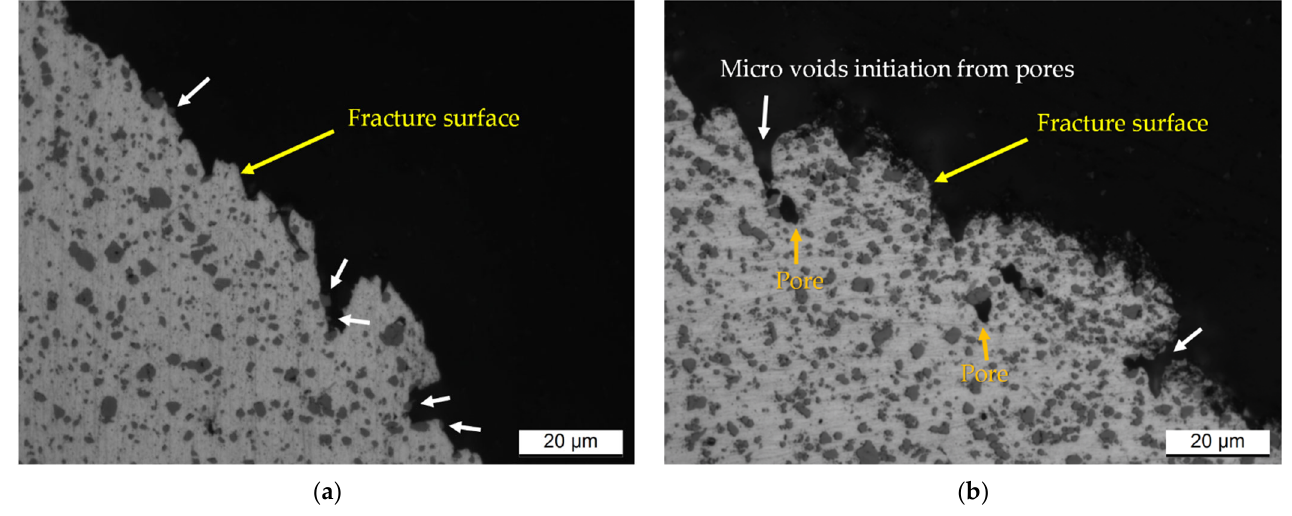
Figure 15. Longitudinal sections of the T6** AlSi10Mg0.3 samples showing: ( a ) the Si ‐ particles attached (white arrows) at the fracture surface, ( b ) the pores and the micro ‐ voids initiation from pores.